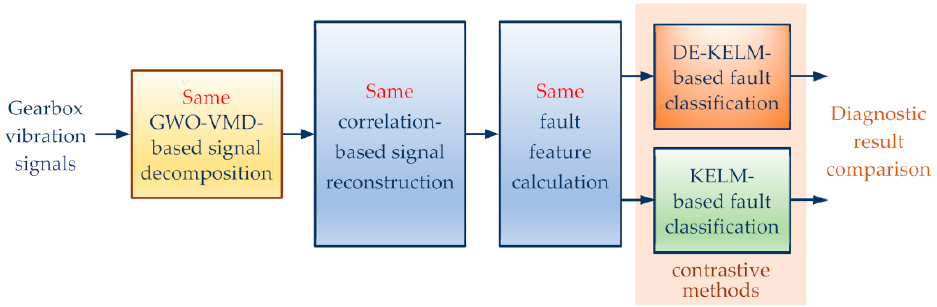
Figure 22. Process of contrast experiment